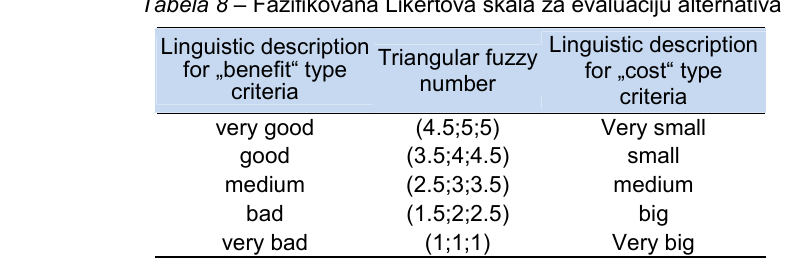
Table 8 – Fuzzyfied Likert scale for the evaluation of alternatives Таблица 8 – Фаззифицированная шкала Лайкерта для оценки альте